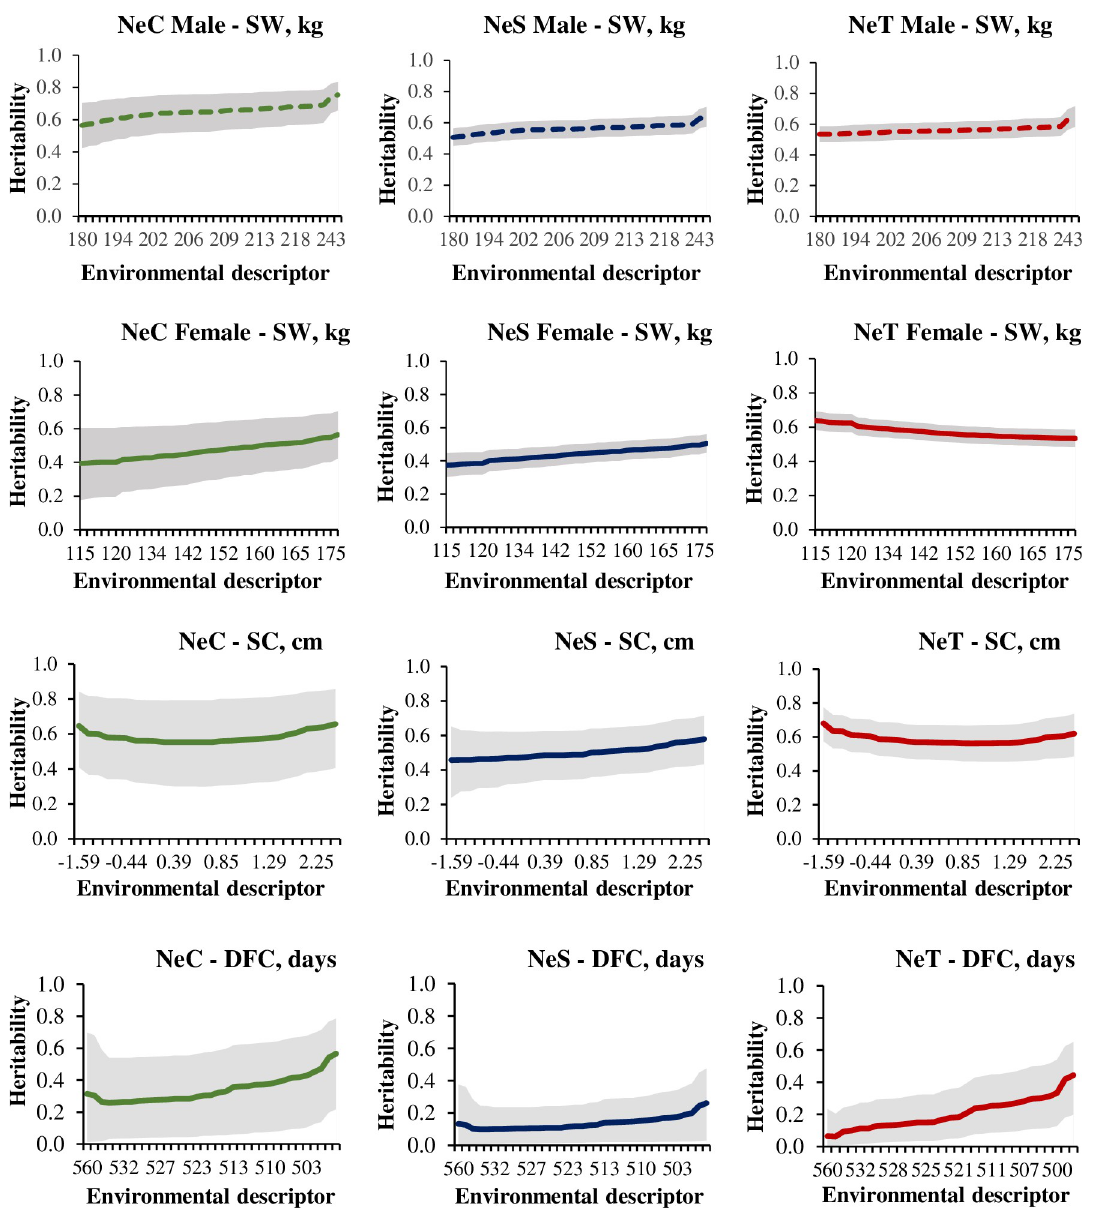
Fig 1. Heritability estimates of Selection Weight (SW, kg) in males and females, Scrotal Circumference (SC, cm), and Days at First Calving (DFC, days) along the environmental descriptor for in three Nellore cattle lines (NeC, control; NeS, selection; and NeT, traditional